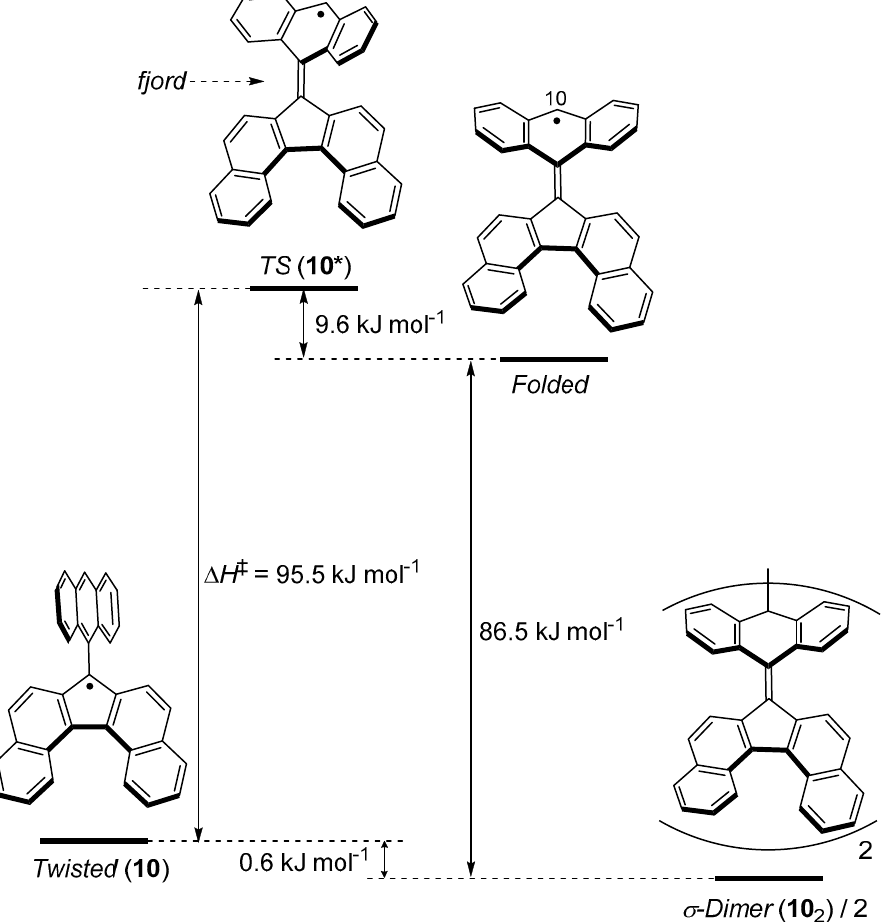
Figure 11. Energy diagram for twisted 10 to 10 2 ( σ -dimer) calculated with the UB3LYP/6-31G** method.